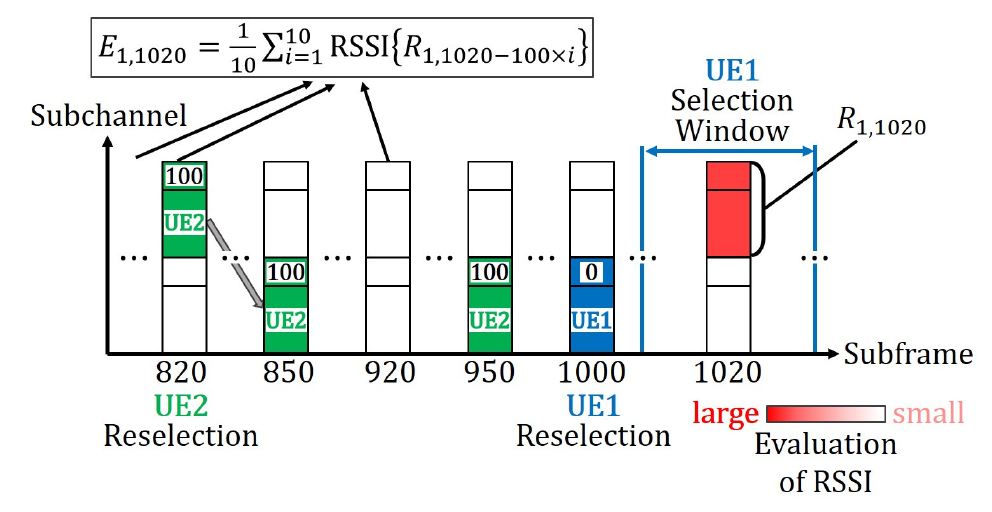
Figure 6. An example of evaluating RSSI for released resources.